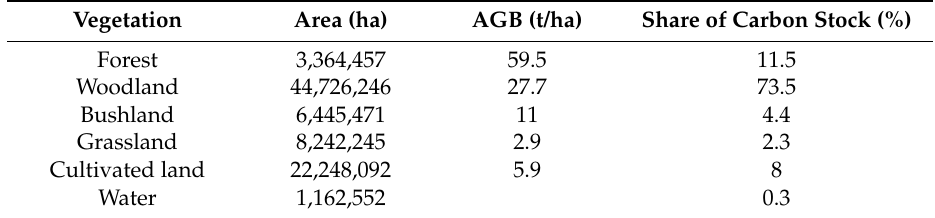
Table 1. Above ground biomass (AGB) by vegetation type: National Forestry Resources monitoring and Assessment (NAFORMA) Main Report